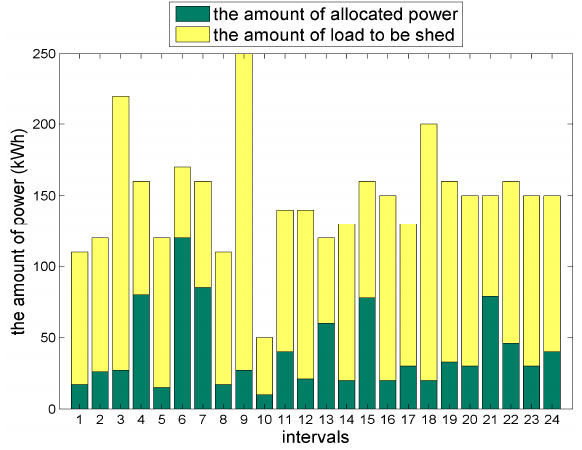
Figure 6. The amount of load to be shed of Load 5 in 25% test scenario.